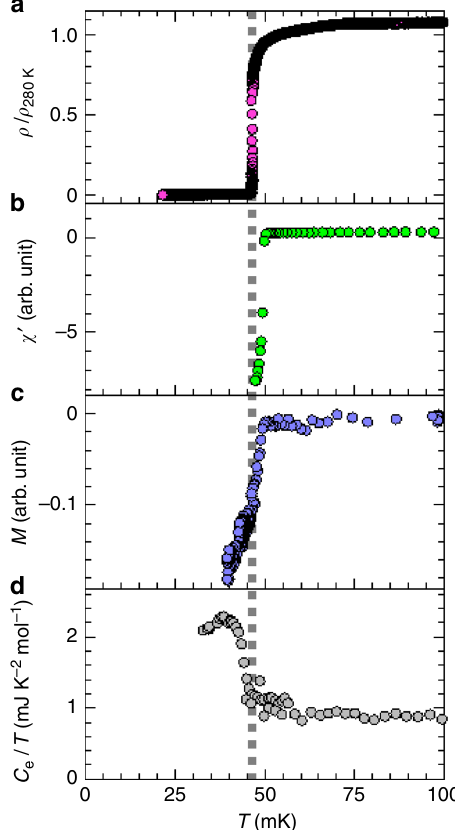
Fig. 7 Physical properties around T c of quasicrystal. Temperature dependence of the normalized electrical resistivity ( a ), the real part of the ac magnetic susceptibility ( b ), the dc magnetization at external magnetic fi eld of approximately 4 mOe ( c ), and the electronic part of the speci fi c heat divided by temperature ( d ), for the QC sample. The broken line marks the transition temperature T c (cid:11) 0 : 05 K